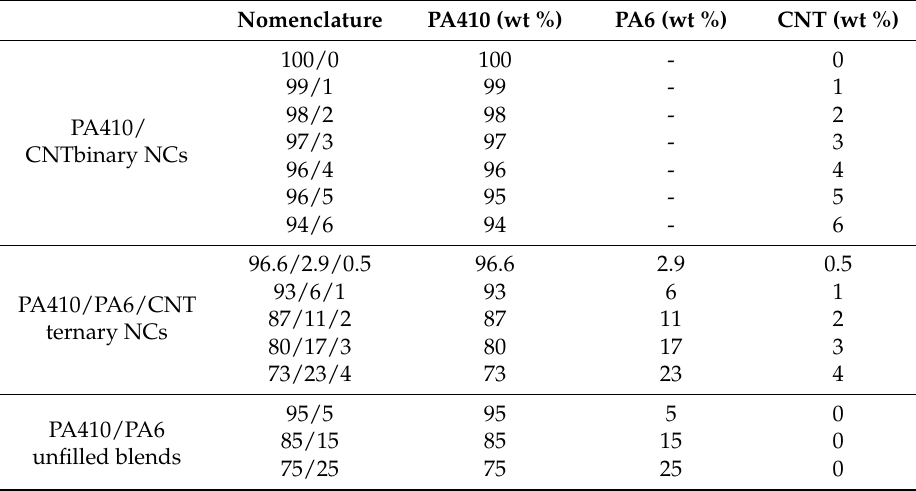
Table 1. PA410, PA6 and CNT wt % content in the compositions